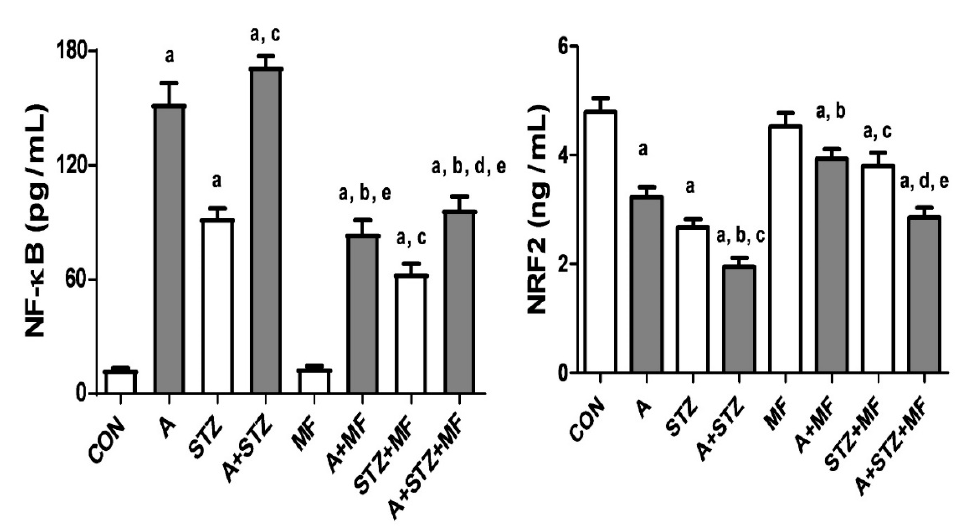
Figure 2. The renal concentration of nuclear factor-kappa B (NF- κ B) and nuclear factor erythroid 2-related factor 2 (Nrf2) in control rats, and rats treated with metformin (MF), adenine (A), and streptozotocin (STZ) alone or in combination. Each column and vertical bar represent mean ± SEM ( n = 6). Differences between the groups were assessed by one-way analysis of variance (ANOVA) followed by Bonferroni’s multiple comparison test, a denotes significant difference between control group vs. different groups; b denotes significant difference between the group given A alone vs. other groups treated with A; c denotes significant difference between the group given streptozotocin (STZ) alone vs. other groups treated with STZ; d denotes significant difference between the group given A + STZ vs. other groups treated with A + STZ; e denotes significant difference between the group given MF only vs. other groups treated with MF.